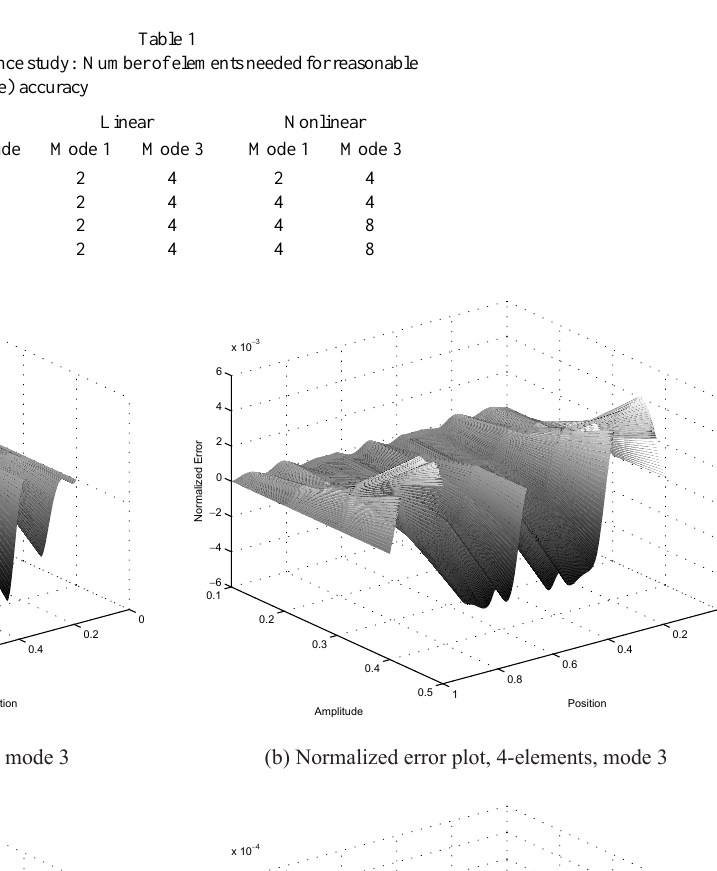
Table 1 Convergencestudy: Numberofelementsneededforreasonable